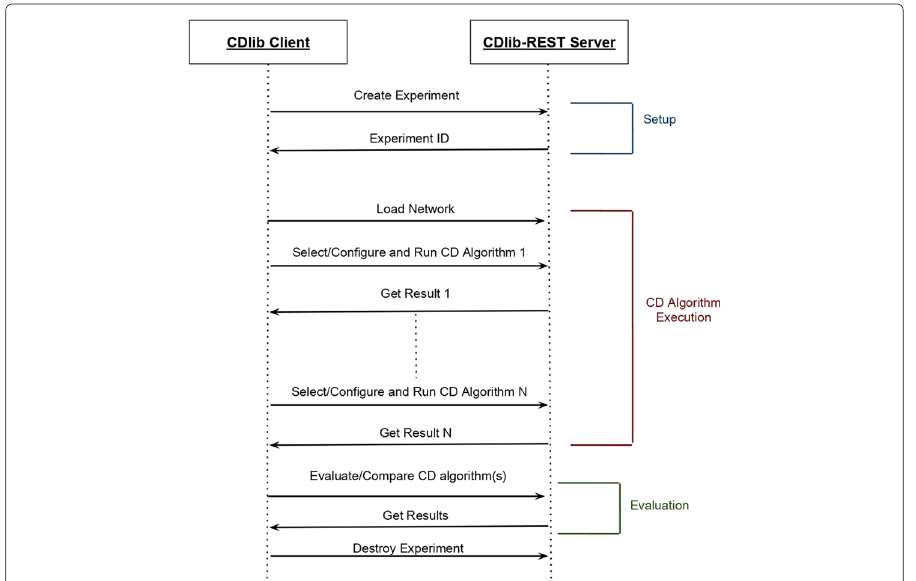
Fig. 3 CD LIB -REST example of workflow of CD LIB